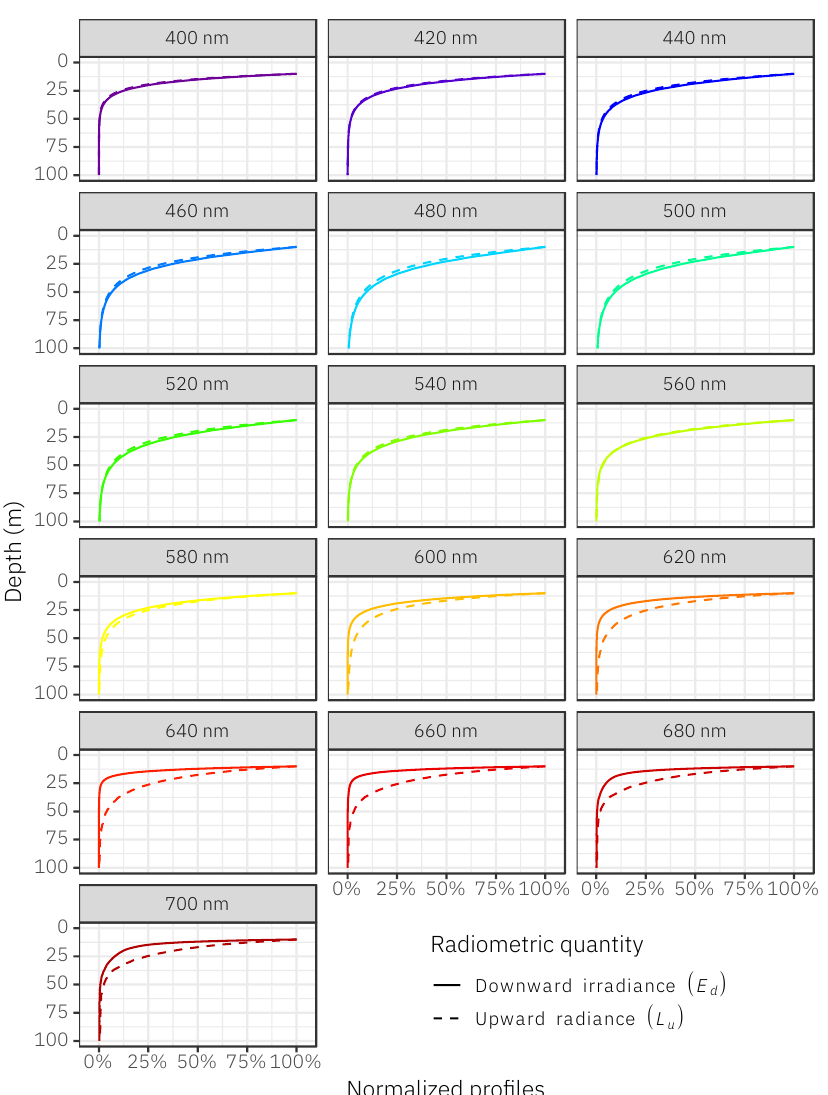
Figure 4. Comparison of downward irradiance ( E d ( z ) ) and upward radiance ( L u ( z ) ) for one example light profile measured under-ice. Profiles were normalized to the measured radiometric value at 10 m depth (under the subsurface light maximum) in order to emphasize the similar shape between E d ( z ) and L u ( z ) .